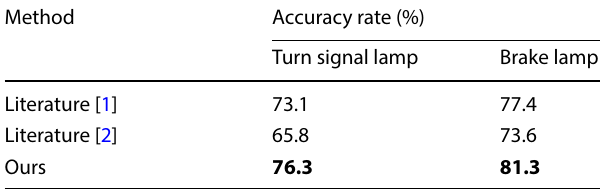
Table 7 Algorithm